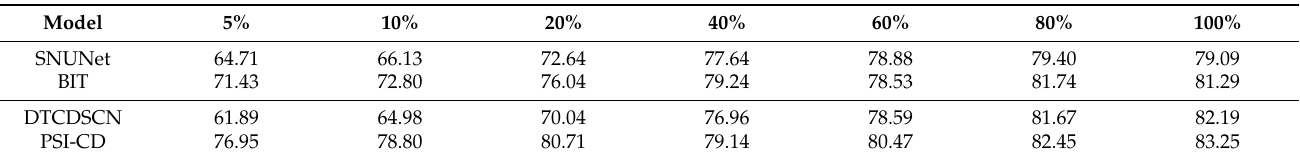
Table 3. Comparison of change detection results of different methods on WHU dataset with different data volumes (unit: %).